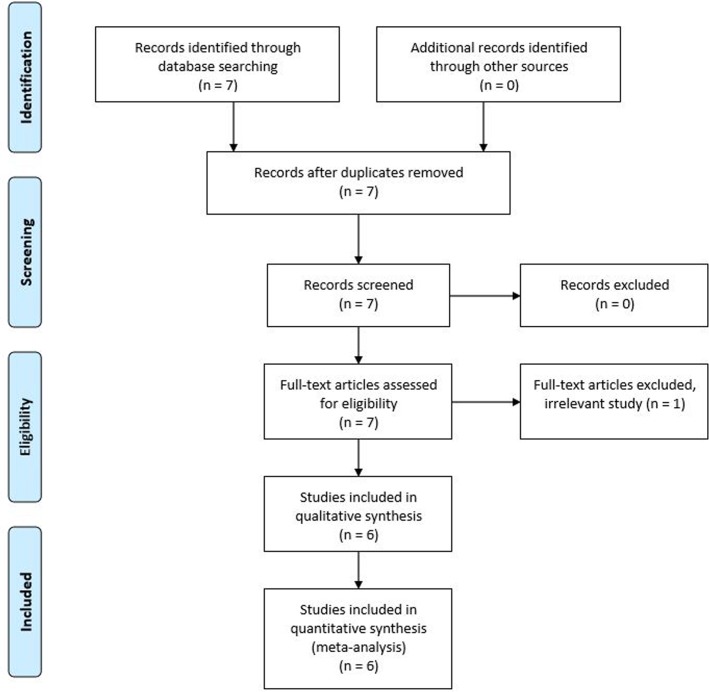
Flow chart of study selection.